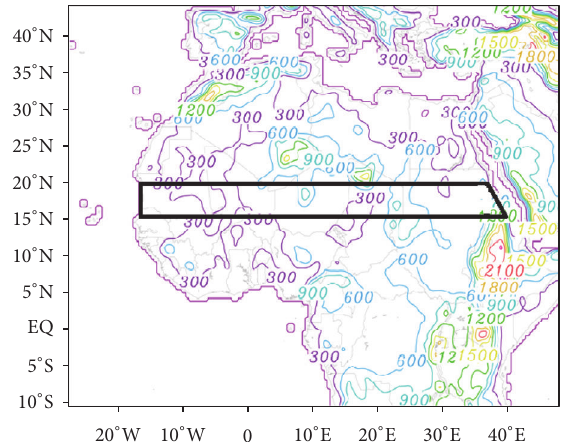
Figure 1: Topography of the simulation domain (West Africa) and the reforested zone (between 15 ∘ N and 20 ∘